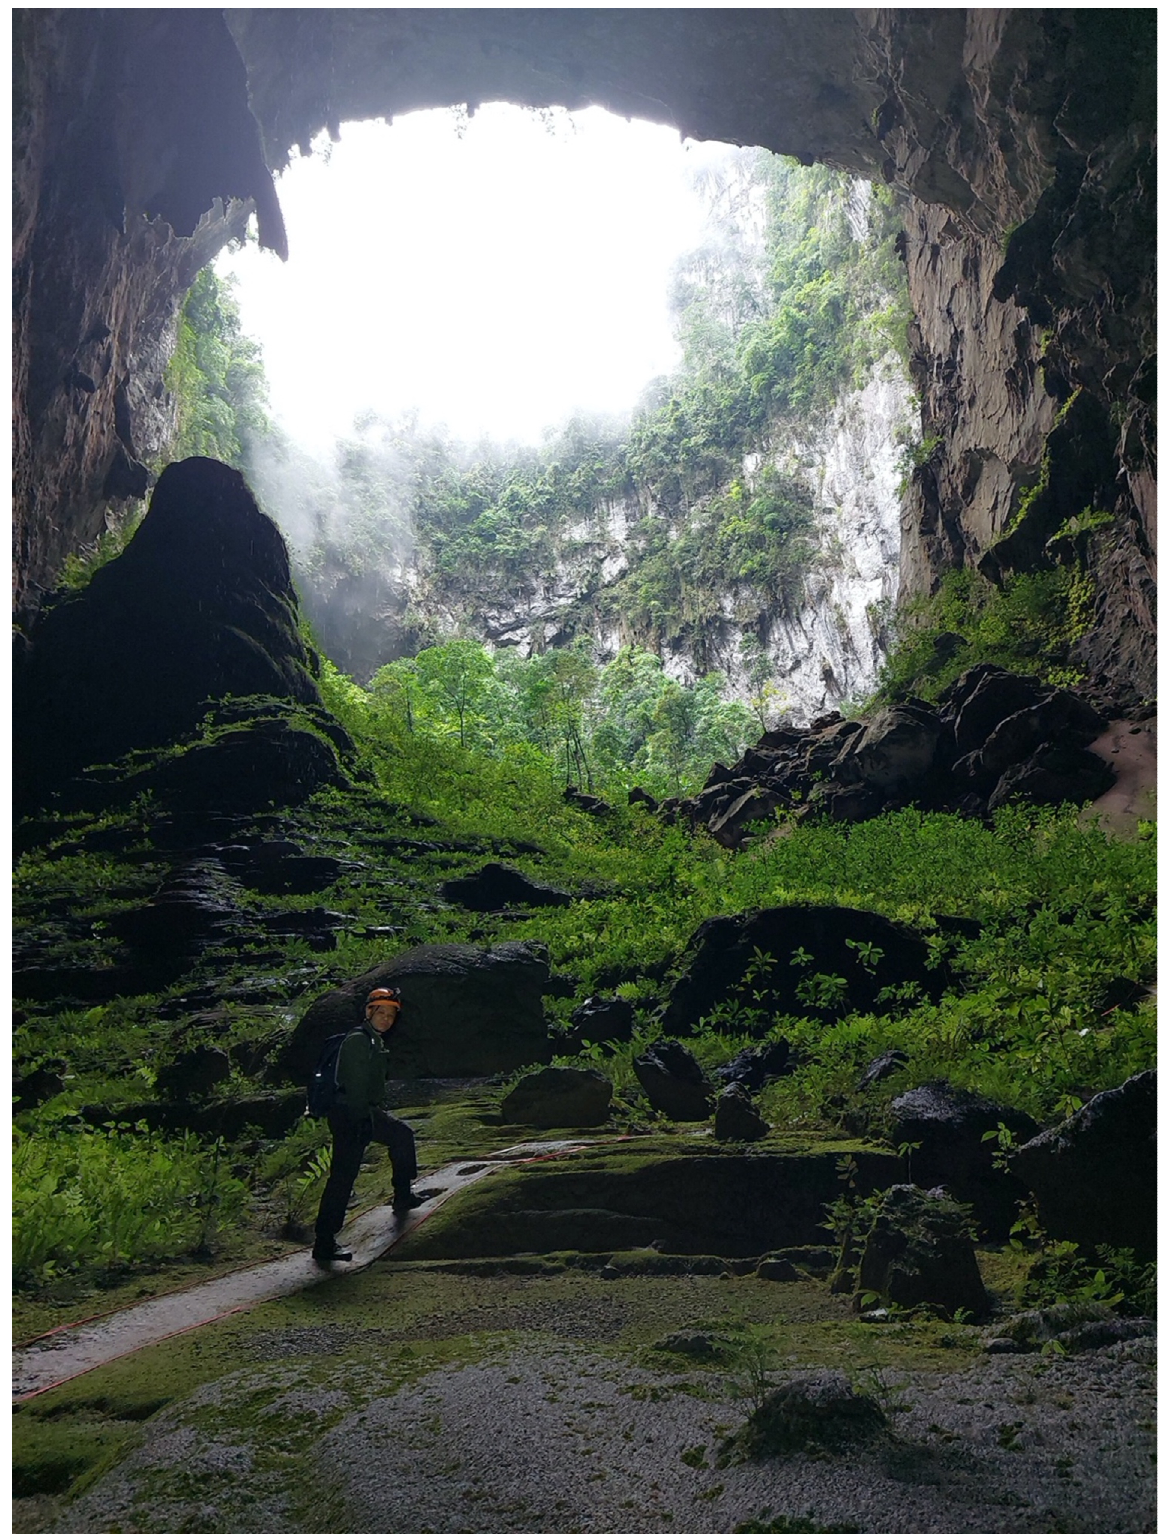
Figure 8. A scientifically designed narrow footpath inside Son Doong Cave must be followed by every visitor to avoid negative impact on the natural environment. Photo: Vu Dinh Thong .